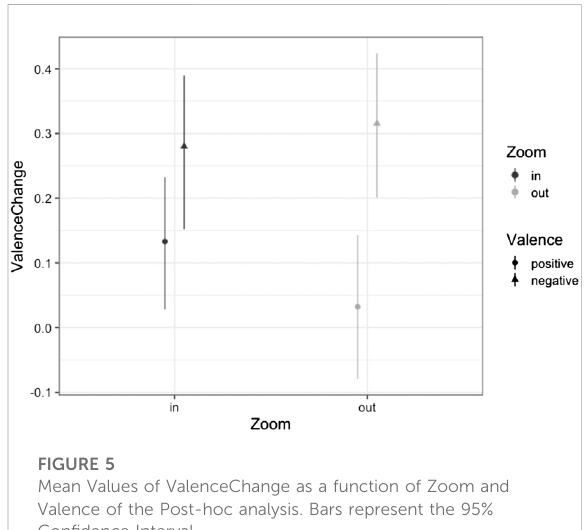
FIGURE 5 Mean Values of ValenceChange as a function of Zoom and Valence of the Post-hoc analysis. Bars represent the 95% Con fi dence